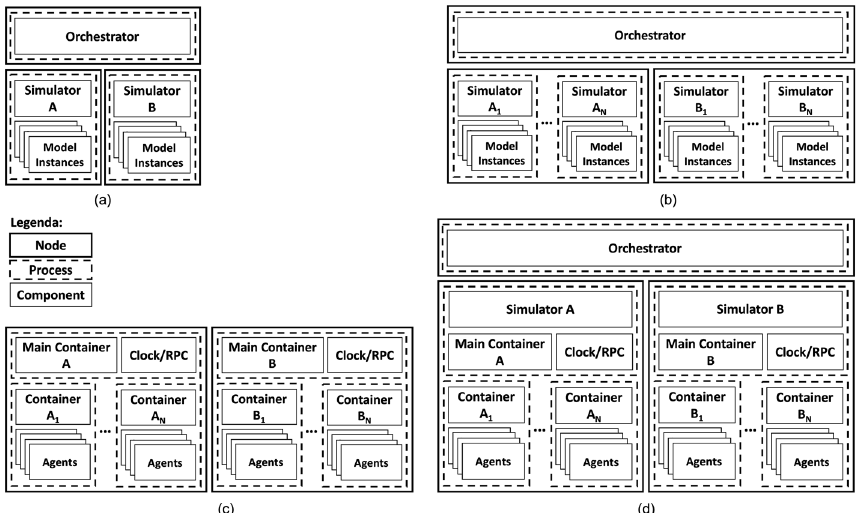
Fig. 4 The proposed co-simulation benchmark configurations: ( a ) Classic Co-simulation, ( b ) Multi-process Co-simulation, ( c ) Multi-Agent System as Co-simulation framework, and ( d ) Classic Co-simulation configuration with encapsulated multi-process Multi-Agent